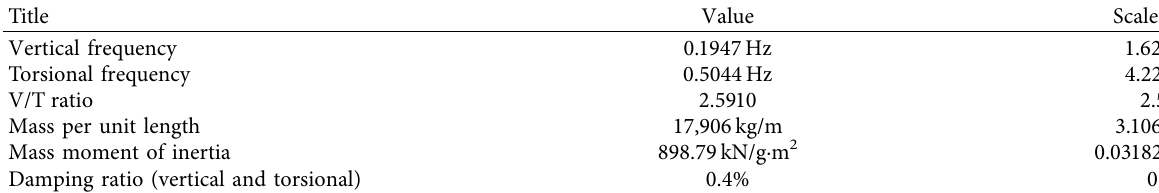
Table 1: Parameters of the scaled model cross section.